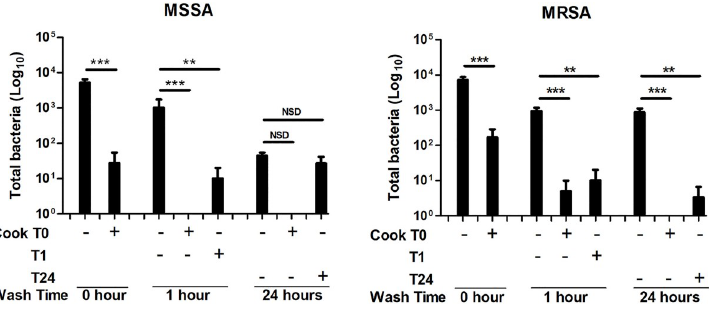
Fig 4. Cigarette lighter heating of S . aureus -"spiked" Hydromorphone-CR prepared in cookers/filters decreases the bacterial burden in the injected drug solution. S . aureus -spiked samples in Hydromorphone-CR-containing Cookers/Filters were heated with a cigarette lighter (holding the flame under the cooker until bubbling) during either the initial wash or at the subsequent 1-hour or 24-hour second wash. Heating reduced S . aureus bacterial recovery by approximately 2 log10 when performed immediately after bacterial contamination, but delayed heating was less effective. Significance was assessed by one way Anova with Tukey’s correction for multiple comparisons. �� P < 0.01, ��� P < 0.001, NSD indicates no statistically significant